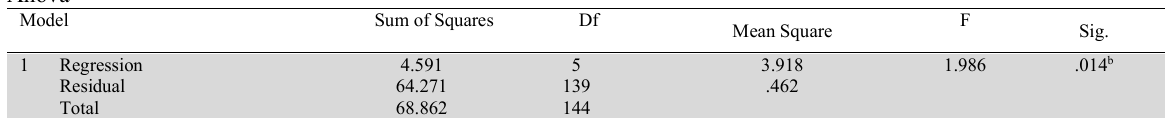
Coefficients a Model